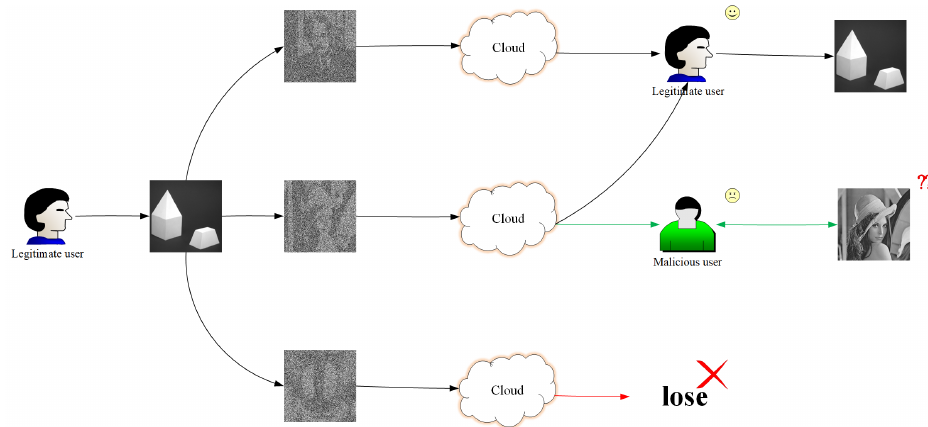
Figure 3. Our scheme, k = 2, n = 3.